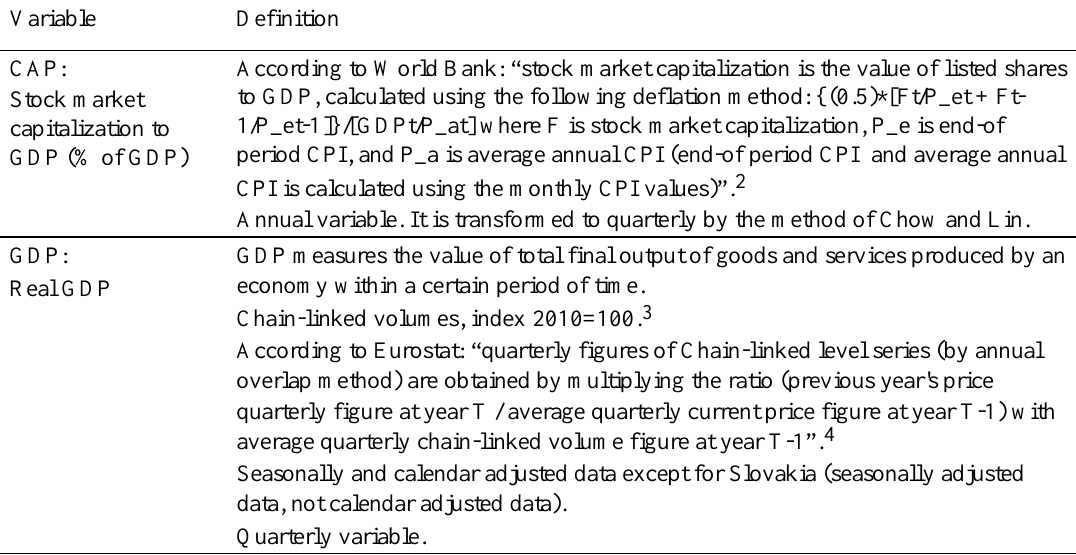
Table 1 . Definition of variables